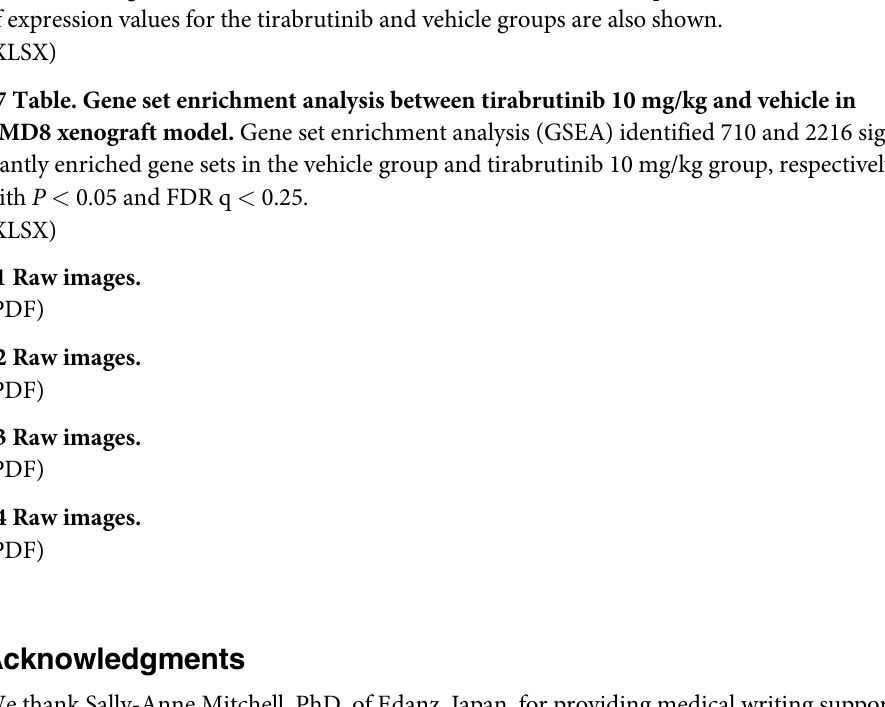
S5 Table. Sorted phosphosites of BTK-related effectors in both TMD8 and U-2932 cells. Phosphosites of BTK-related effectors in both TMD8 and U-2932 cells were sorted from S3 Table and S4 Table and the responsible kinase and/or function of each phosphorylation site are described. S6 Table. Comprehensive gene expression analysis using microarray in TMD8 xenograft model. The microarray data were normalized to the 75 th percentile signal intensity as recom- mended by Agilent. Welch’s t -test of log-converted expression values was performed to find significant differentially expressed genes between the tirabrutinib and vehicle groups. Fold changes, nominal P -values and q-values of the differentially expressed genes are shown. Benja- mini-Hochberg method was used as the correction method for the q-value. Geometric means of expression values for the tirabrutinib and vehicle groups are also shown. S7 Table. Gene set enrichment analysis between tirabrutinib 10 mg/kg and vehicle in TMD8 xenograft model. Gene set enrichment analysis (GSEA) identified 710 and 2216 signif- icantly enriched gene sets in the vehicle group and tirabrutinib 10 mg/kg group, respectively, with P < 0.05 and FDR q <